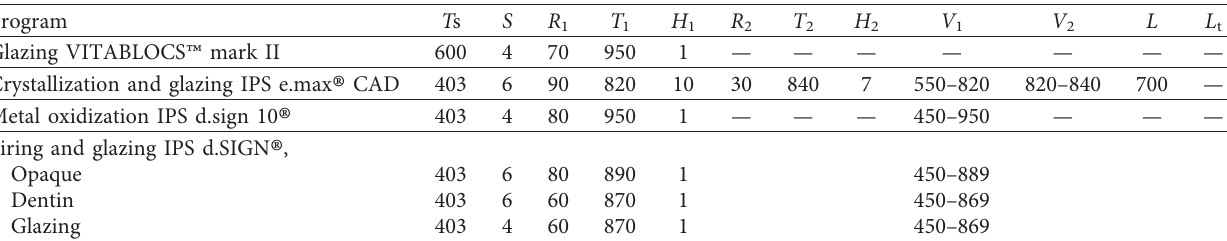
Figure 1: Sample tree design for metal bracket bonded on different surfaces treated of conventional and machinable ceramic. Table 2: Program for crystallization and